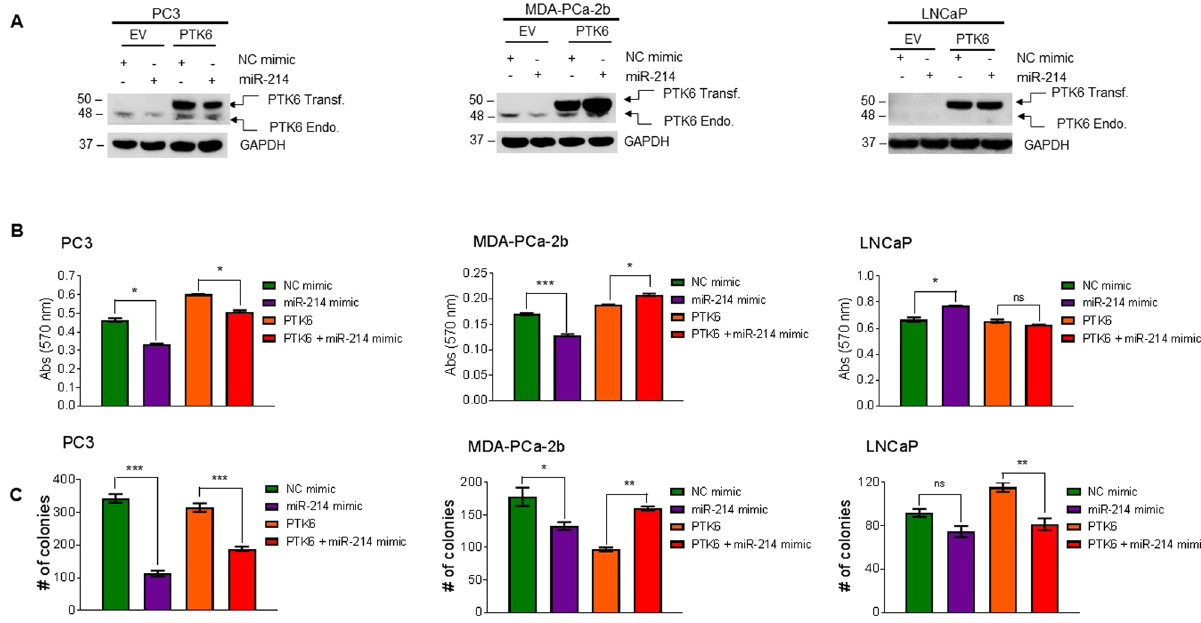
Figure 5. Effects of PTK6 overexpression on prostate cancer cell proliferation and colony formation. ( A) Western blot analysis: PC3, MDA-PCa-2b, and LNCaP cells were co-transfected with empty vector (EV) or PTK6 plasmids as indicated for the first 24 h and then transfected with NC or miR-214 mimic for an additional 24 h. Cell lysates (40 µ g) were immunoblotted with anti-PTK6 and anti-GAPDH antibodies. ( B ) MTT assay: PC3, MDA-PCa-2b, and LNCaP cells were transfected as indicated in ( A ) and after 48 h, cell proliferation was analyzed by MTT assay. ( C ) Cell colony formation assay: PC3, MDA-PCa-2b, and LNCaP cells were transfected with EV or PTK6 plasmids for 24 h and then transfected NC or miR-214 mimic for an additional 24 h. Cells were then trypsinized, counted, and re-plated in 6-well plates for analysis using colony formation assays.